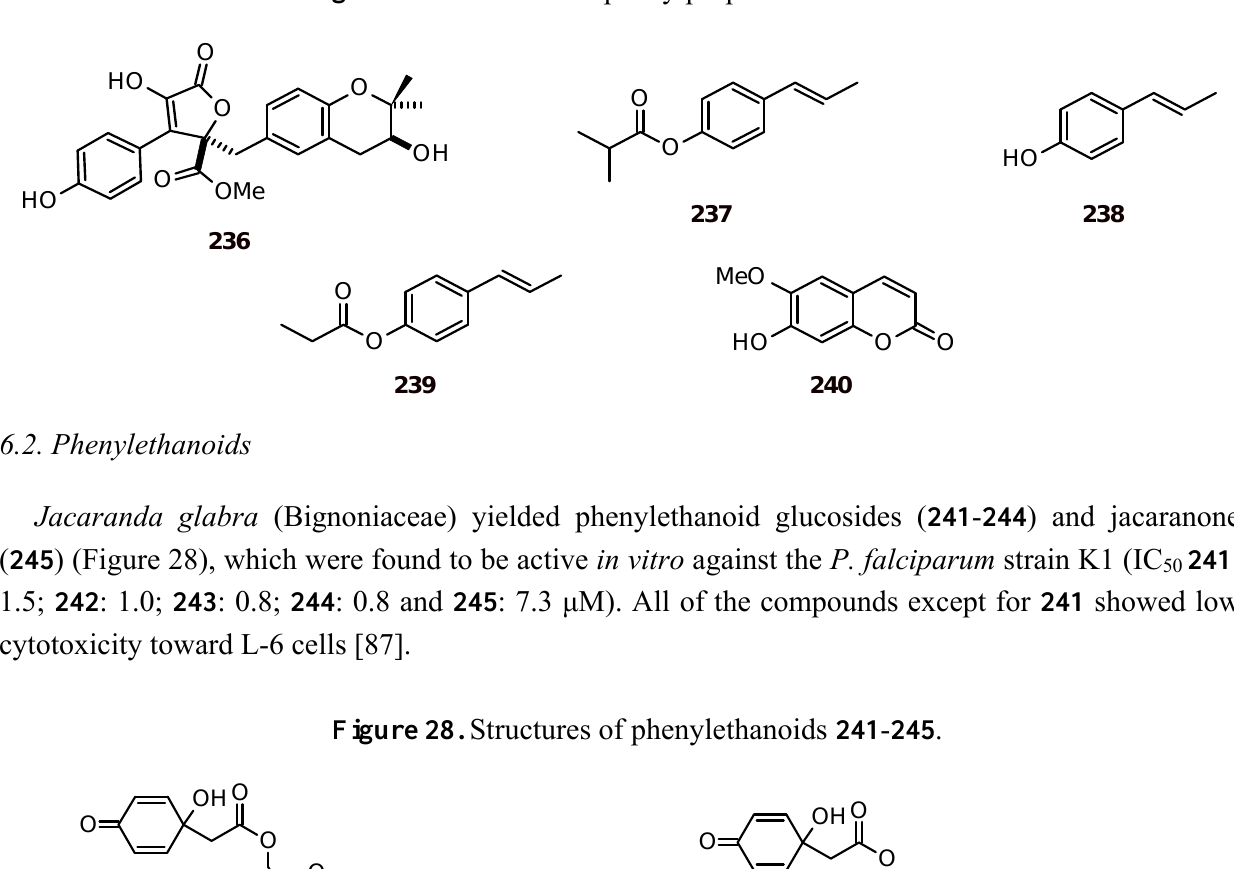
Figure 27. Structures of phenylpropanoids 236 - 240 .